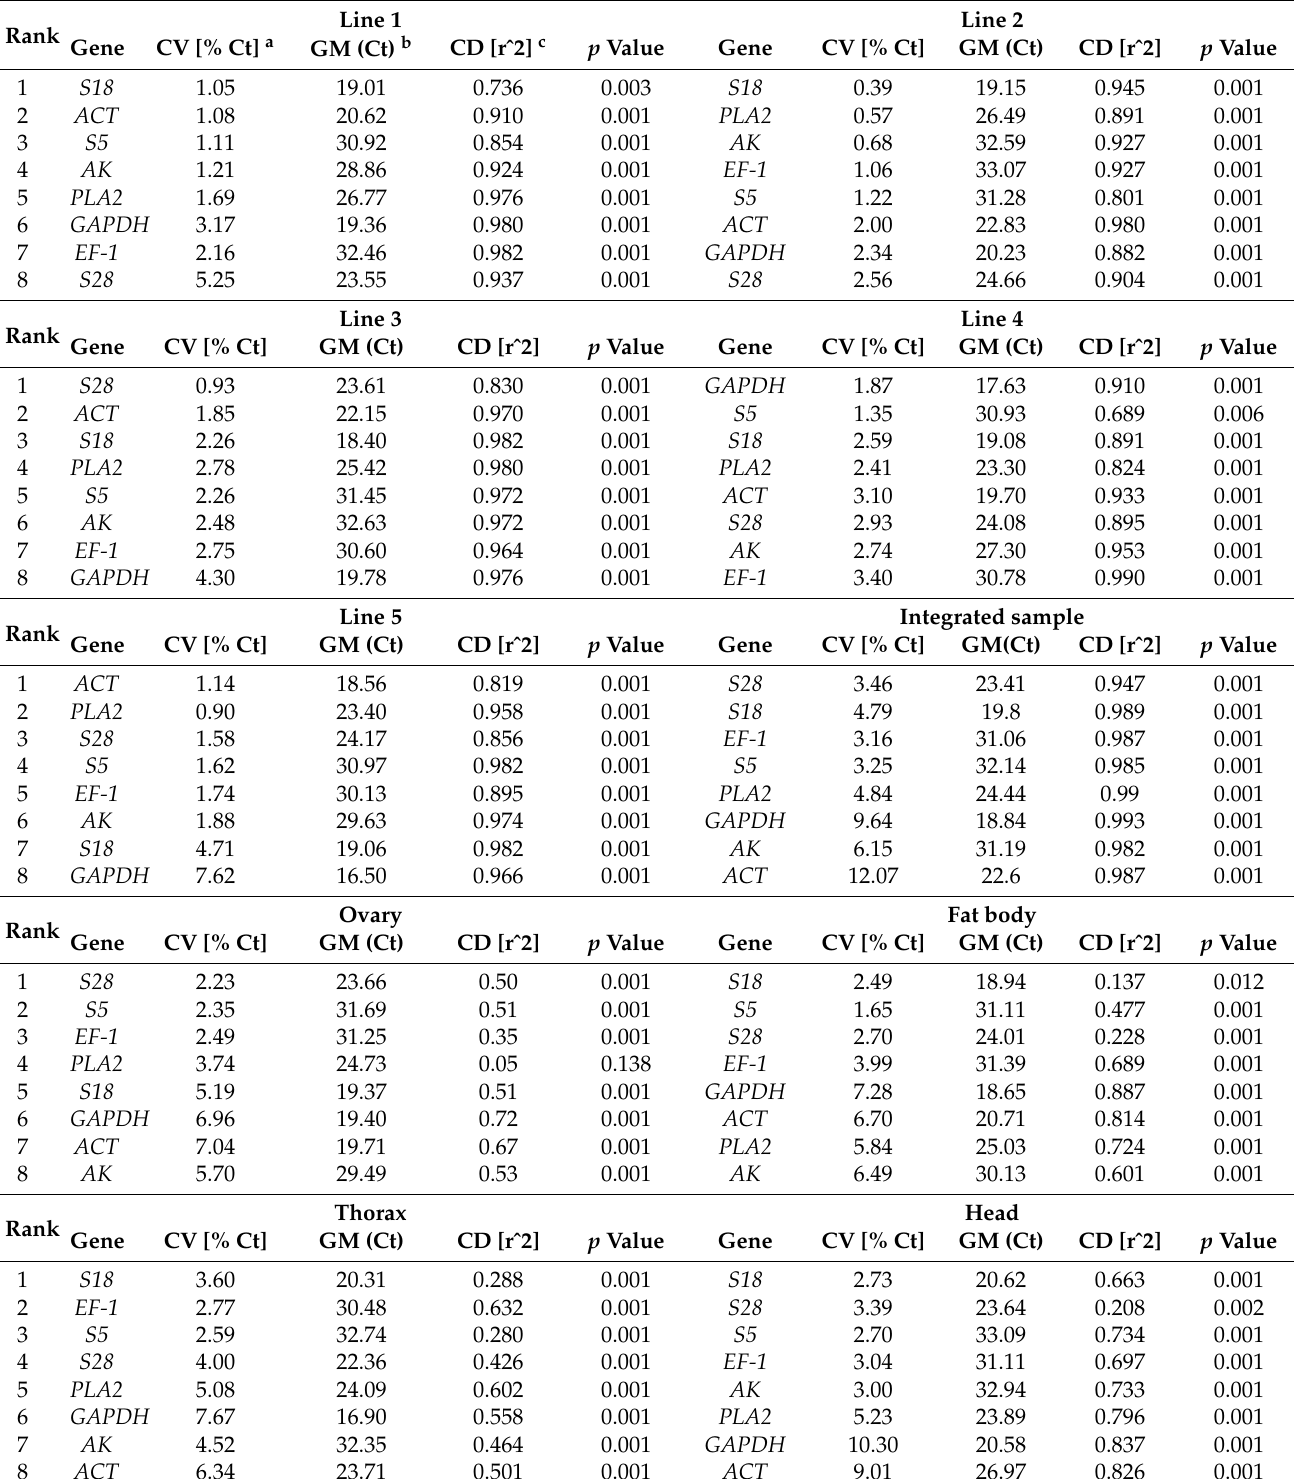
Table 3. The values for gene expression stability derived from Best-analysis Keepers of the eight candidates for reference genes. The coefficient of variation is represented by the notation CV [% Ct] a . The value that is denoted by GM (Ct) b is the geometric mean of the Ct values. The coefficient of determination is denoted by the notation CD [rˆ 2] c